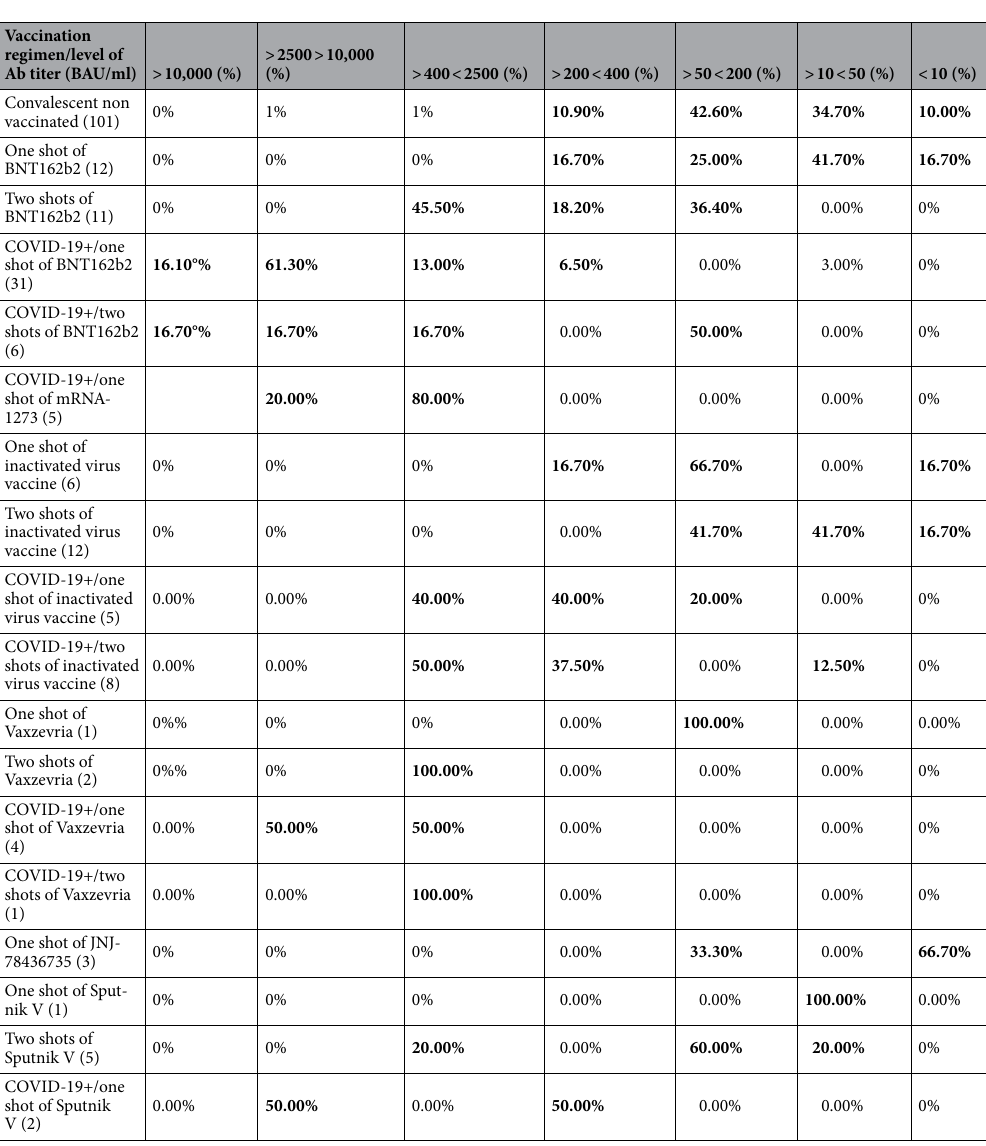
Table 1. The level of induced humoral immune responses after COVID-19 vaccination in percentages. Between parentheses is the number of vaccine recipients in each category. Significant values are in